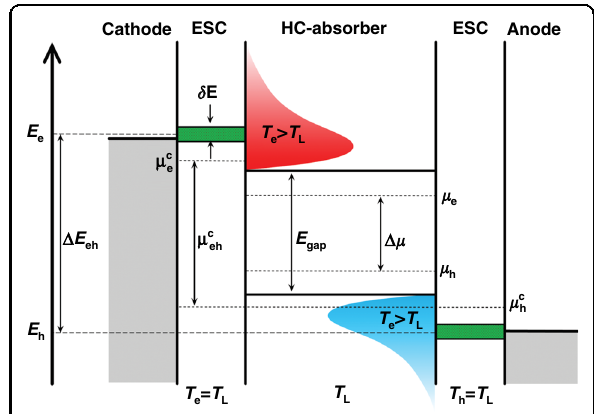
Fig. 11 The energy diagram of a HC-absorber, ESCs, and the respective electrodes. μ c for hot electrons and holes, respectively, and μ c The fi gure is taken with permission from ref.